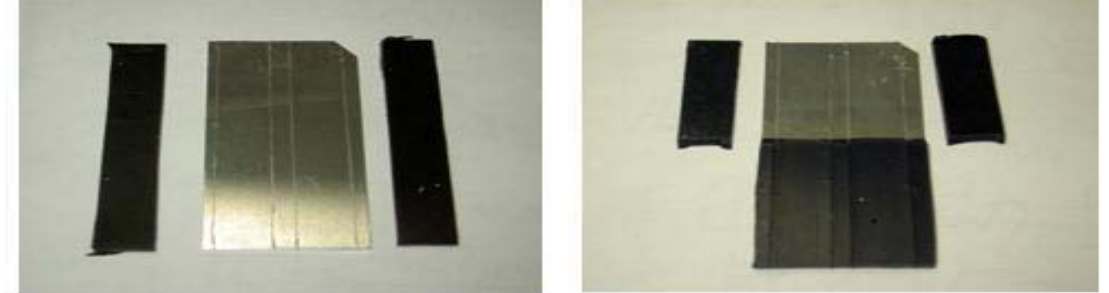
Figure 7. Photographs after T-peel test of untreated and TES treated aluminum substrate and EPDM rubber. (a) aluminum substrate untreated by TES (Left). (b) TES treated aluminum substrates